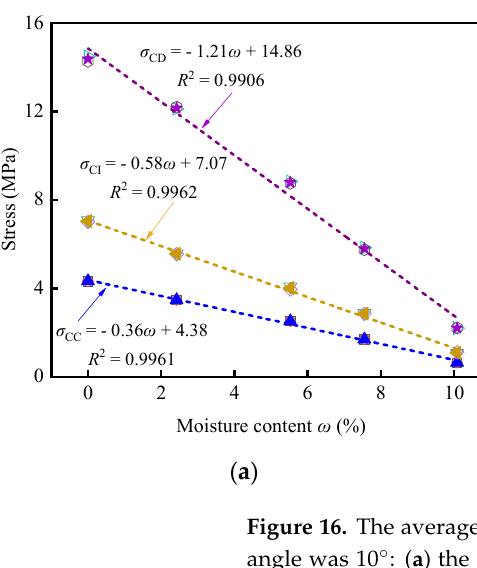
Figure 15. Curves of cumulative AE parameters (counts and energy) versus time at different mois- ture contents when the inclination angle was 10°: ( a ) ω = 0%; ( b ) ω = 2.42%; ( c ) ω = 5.53%; ( d ) ω = 7.55%; ( e ) ω = 10.08%.